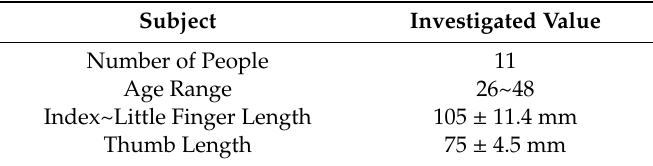
Table 2. Di ff erent hand sizes of adult males investigated in this study. Table 2. Different hand sizes of adult males investigated in this study.